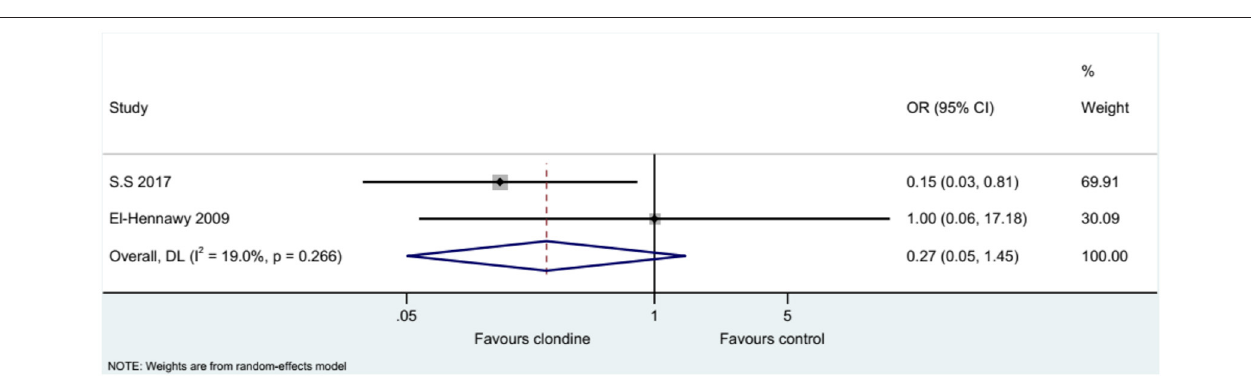
FIGURE 7 | Subgroup analysis of pain score by the dosage of clonidine.